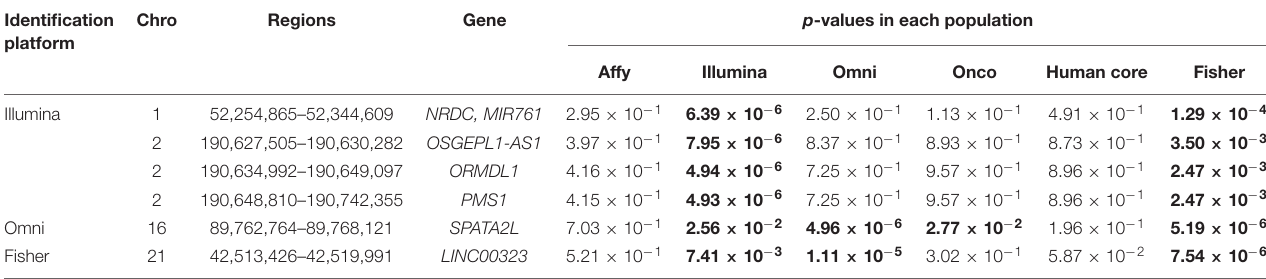
TABLE 7 | Regions reaching suggestive significance level of 10 − 5 by common variants analysis. Identification Chro Regions